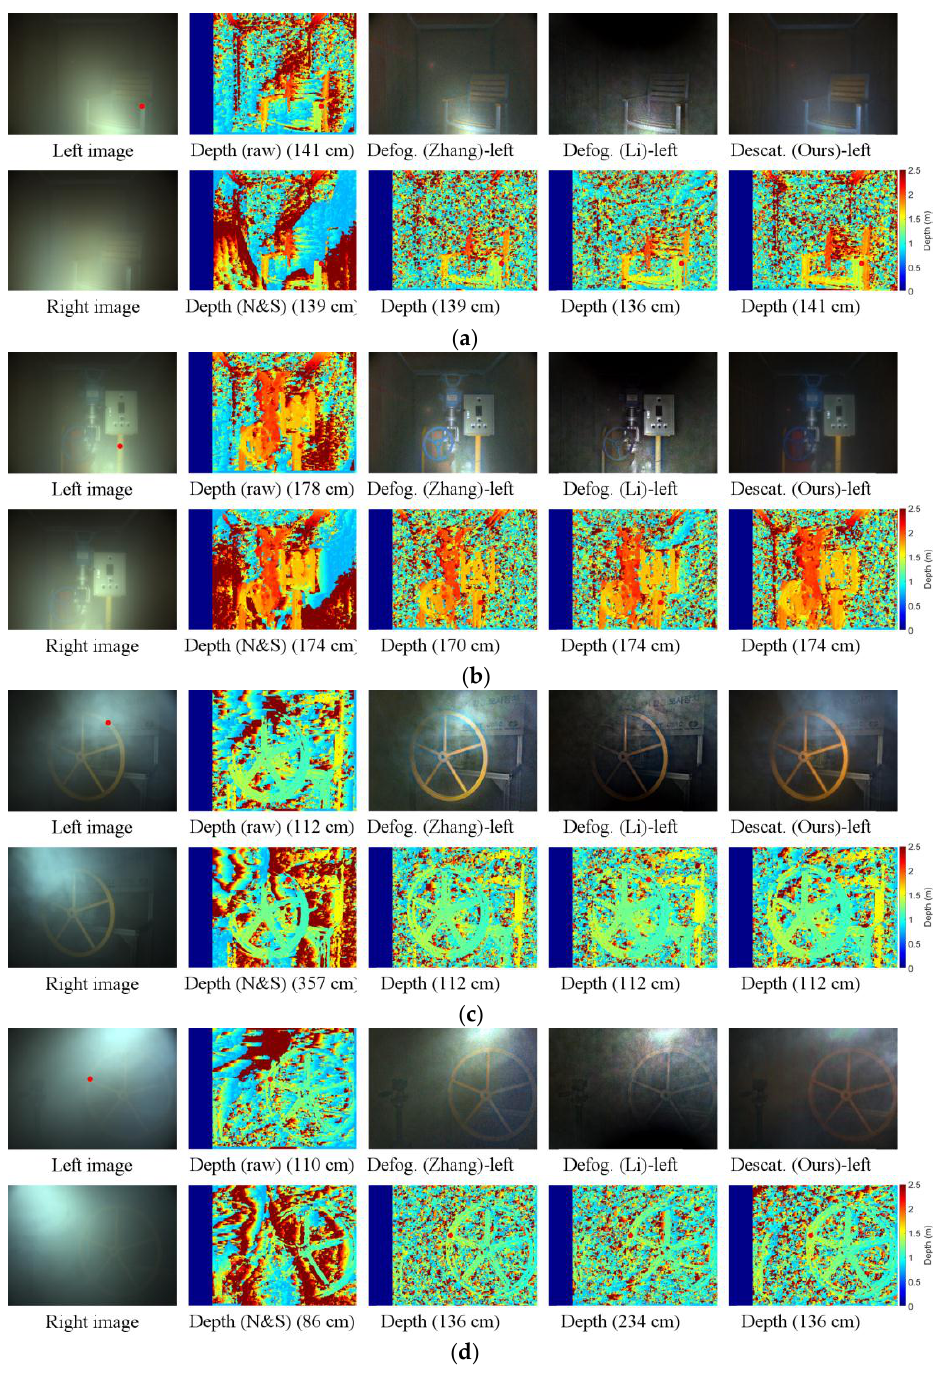
Figure 8. Experimental results; the stereo method is NSSD: ( a ) Lighting 1— V = 4.24 m; ( b ) Lighting 1— V = 3.39 m; ( c , d ) Lighting 2—non-uniform. The first column is corrupted images; the second column shows the depth maps from input images and those obtained by using method in [40]; the third to last columns are the defogged (or descattered) images and disparity maps using methods in [35,36] and the proposed method, respectively. The number under the every depth map is the measured depth at the red dot.